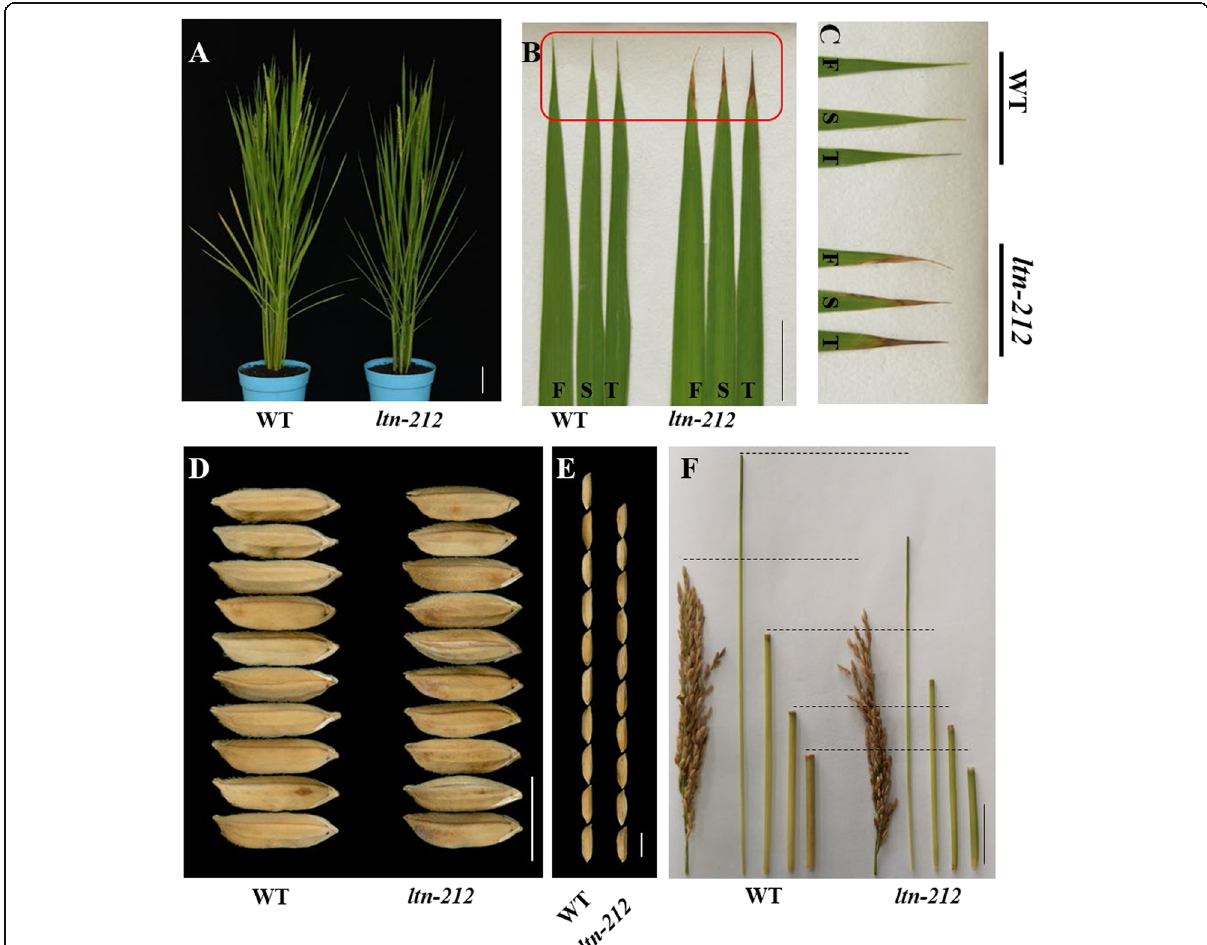
Fig. 1 Leaf tip necrosis and agronomic traits of ltn-212 . a Phenotype of WT and ltn-212 at heading stage (scale bar = 10 cm). b Leaf tip necrosis identification of WT and ltn-212 at heading stage (scale bar = 5 cm). c Enlarge of red part of Fig. b. d-e The phenotype of grain width and grain length (scale bar = 10 mm). f Comparison of panicles and culm length of WT and ltn-212 (scale bar = 5 cm).** indicates significance at P ≤ 0.01 and * indicates significance at P ≤ 0.05 (Student ’ s t test). F: The first top leaf. S: The second top leaf. T: The third top